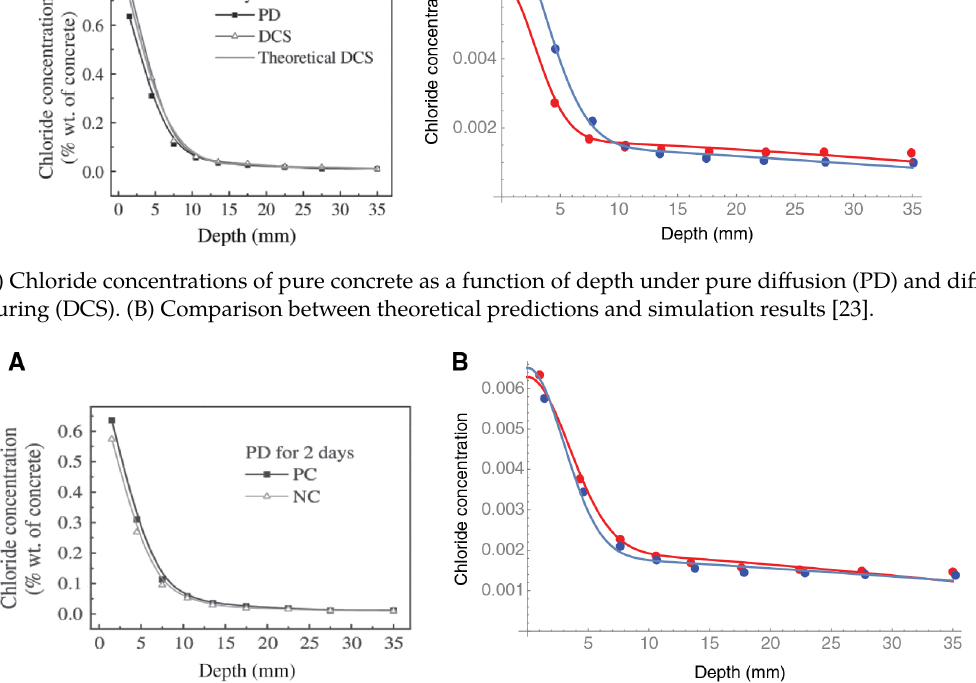
Figure 6: (A) Chloride concentrations of pure concrete as a function of depth in powdered concrete (PC) and nano-TiO on cement (NC). (B) Comparison between theoretical predictions and simulation results